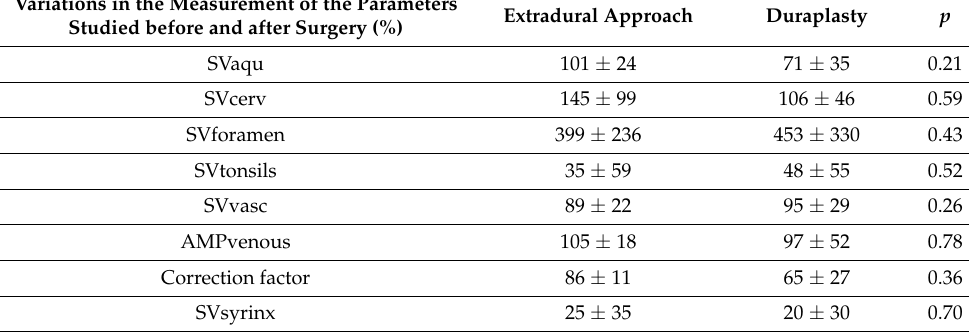
Table 5. Comparison of hemodynamic and hydrodynamic parameter according to the type of surgery. All results are expressed as a percentage change. This is calculated as the ratio between the preoperative and postoperative values. A change of less than 100% indicates a decrease. A value greater than 100% indicates an increase. SVaqu: stroke volume of CSF in Sylvius aqueduct, SVforamen: stroke volume of CSF at the foramen magnum level, SVtonsils: stroke volume of tonsils (it is analyzed by a semi-automatic segmentation of the tonsils according to the same method as the CSF, this allows a quantification of the pulsatility of the tonsils during a cardiac cycle), SVcerv: stroke volume of CSF at cervical level, SVvasc: stroke volume of arteriovenous system, AMPvenous: amplitude of venous flow curve, SVsyrinx: stroke volume into the